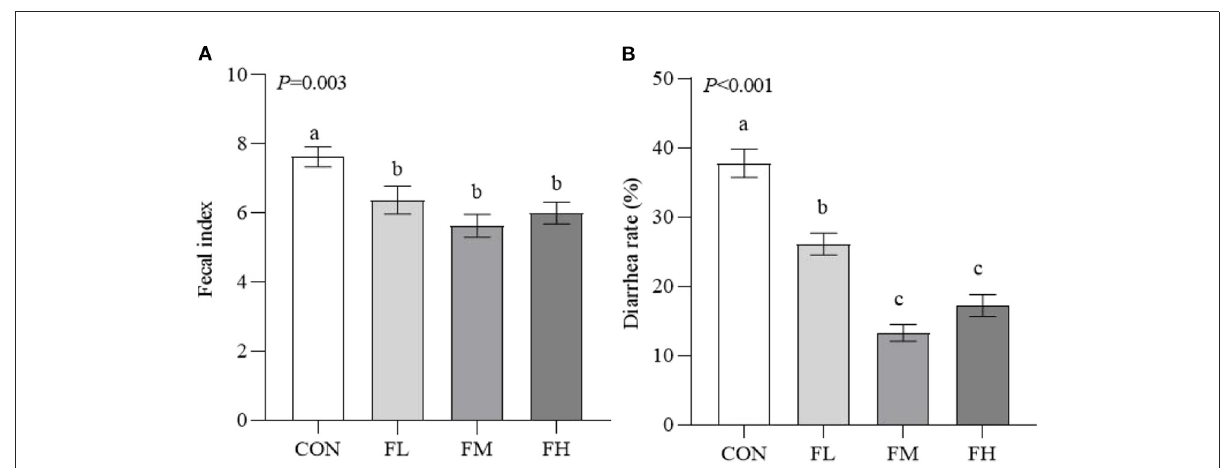
FIGURE2 Effects of fucoidan on the fecal index and diarrhea rate of weaned lambs. (A) Fecal index. (B) Diarrhea rate. CON, control; FL, 0.1% fucoidan (DMI); FM, 0.3% fucoidan (DMI); FH, 0.6% fucoidan (DMI). Data are denoted as mean ± standard error of the mean (SEM) ( n = 6). a,b,c Demonstrate a statistically significant distinction, P <